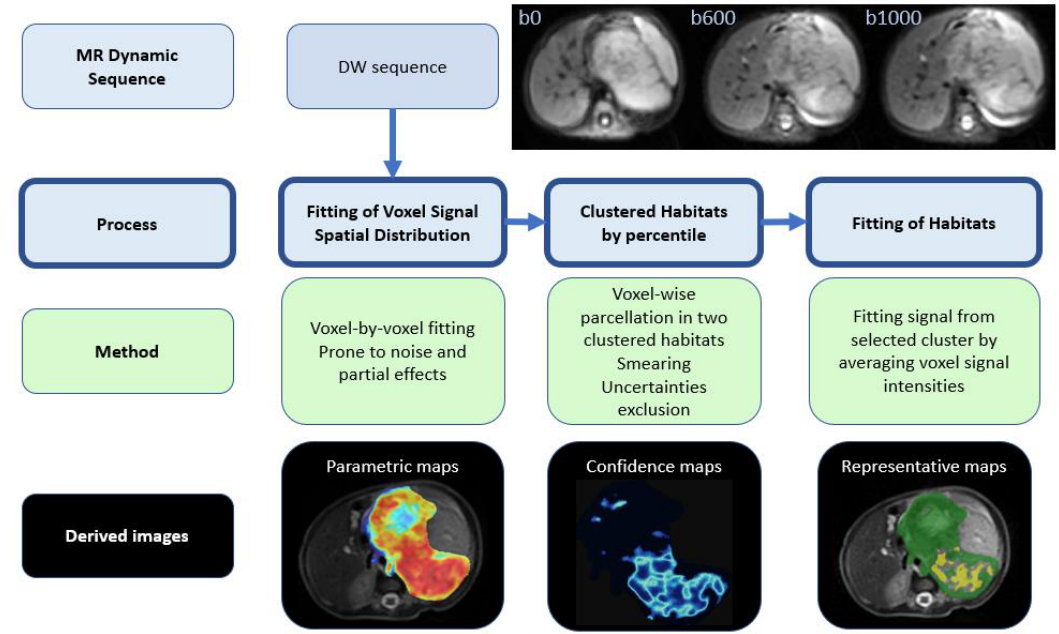
Figure 3. Scheme of the novel Fit-Cluster-Fit strategy. The following ranges were used: parametric maps, red (0.5 · 10 − 3 mm 2 / s)–blue (3.0 · 10 − 3 mm 2 / s); confidence maps, light blue (high voxel uncertainty)–dark blue (low voxel uncertainty); and representative maps, yellow (lower ADC habitat)–green (higher ADC habitat).